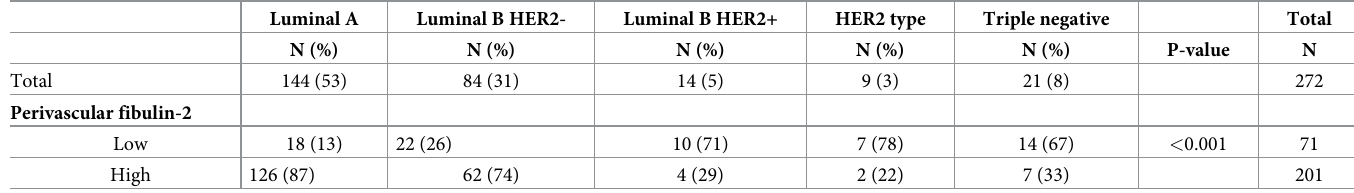
Number of cases (N) and % within molecular subgroups is given according to the St Gallen 2013 consensus. P-values were obtained using Pearson‘s Chi square test. Perivascular fibulin-2 expression was graded on immunohistochemical